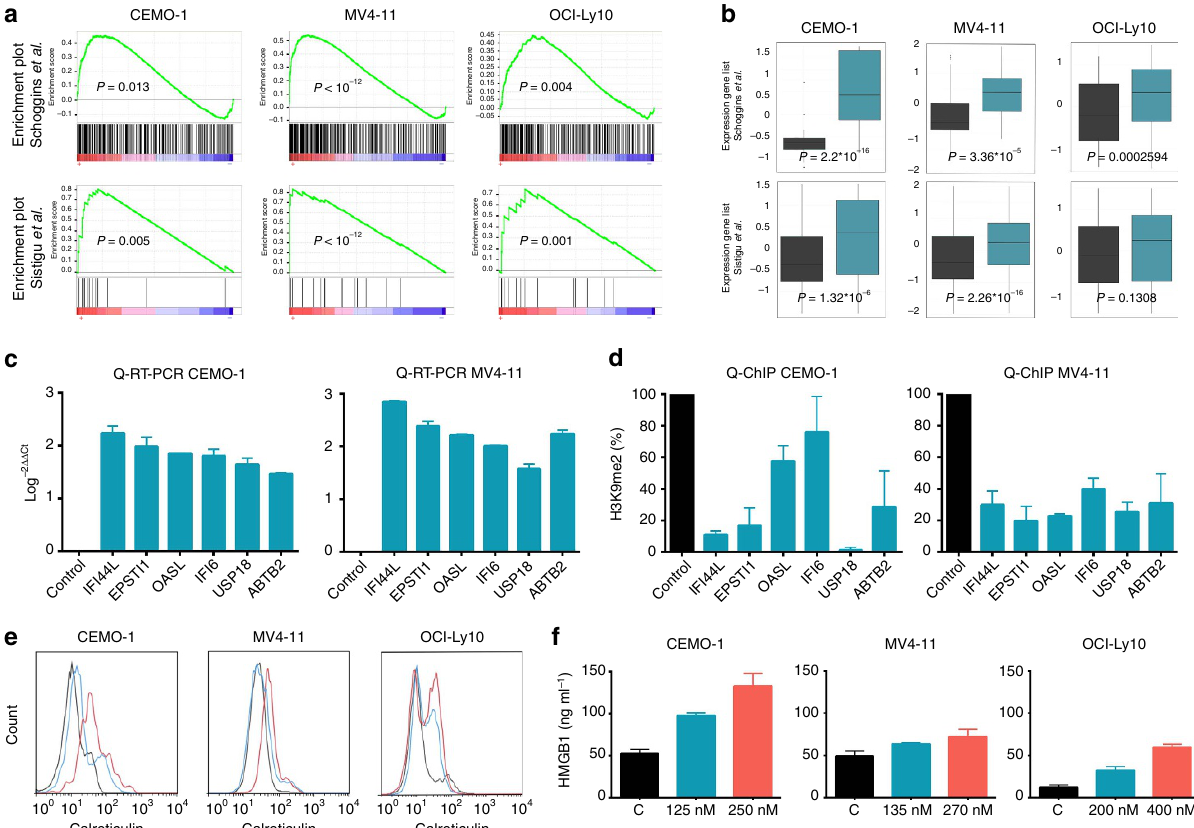
Figure 3 | CM-272 induces type I IFN response and immunogenic cell death. ( a ) Enrichment of ISGs published by Schoggins and colleagues 31 and Sistigu and colleagues 32 in CEMO-1, MV4-11 and OCI-Ly10 cell lines using GSEA. ( b ) Gene expression of ISGs published by Schoggins JW et al. and Sistigu and colleagues after 48h of CM-272 treatment in CEMO-1, MV4-11 and OCI-Ly10 cell lines. ( c ) qRT-PCR validation of ISGs in CEMO-1 and MV4-11 cell lines after 48h of CM-272 treatment. ( d ) qChIP-PCR analysis of ISGs in CEMO-1 and MV4-11 treated for 48h with 250 and 270nM of CM-272, respectively. ( e ) Calreticulin exposure determined by FACS analysis of CEMO-1, MV4-11 and OCI-Ly10 cells after 48h of treatment with GI 25 and GI 50 of CM-272. ( f ) HMBG1 secretion determined by ELISA analysis of supernatants of CEMO-1, MV4-11 and OCI-Ly10 cells after 48h of treatment with GI 25 and GI 50 of CM-272. Error bars indicate s.d. from three